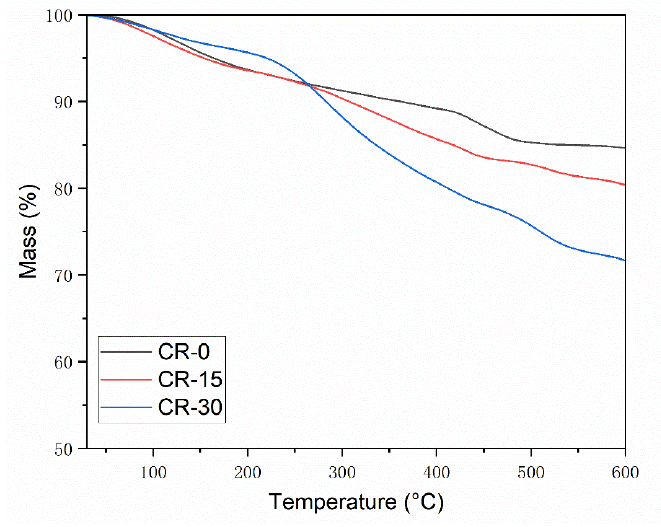
Figure 7. Thermal analysis curves of different cement samples.